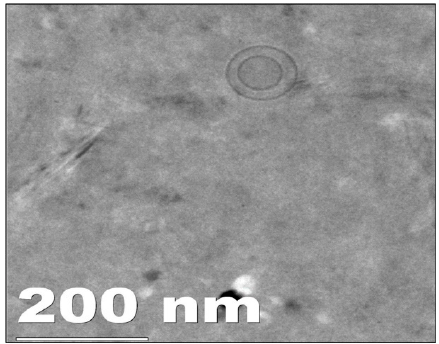
Figure 1. Cryo HR TEM image of optimized liposome (Batch L6).